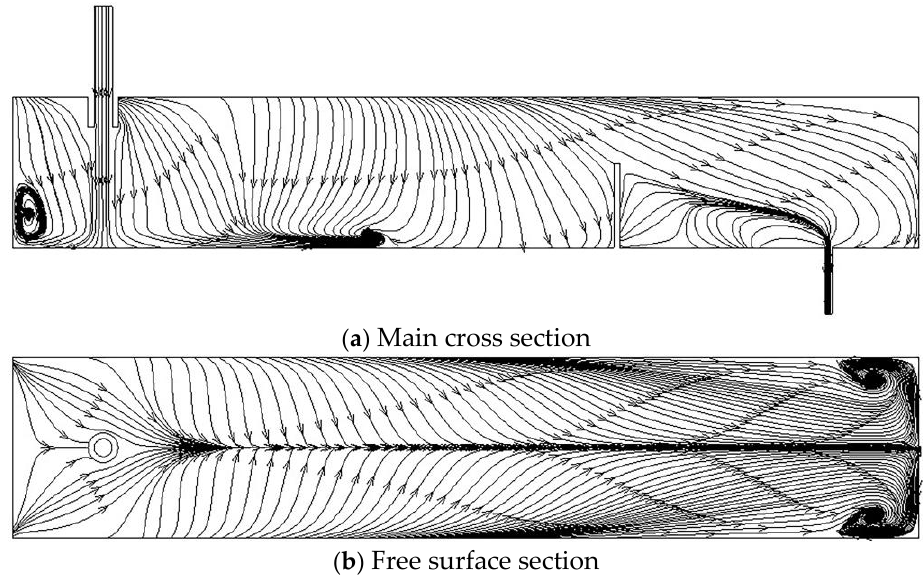
Figure 14. Fluid flow in the case of ideal tracer at 25 s: ( a ) Main cross section; ( b ) Free surface section.